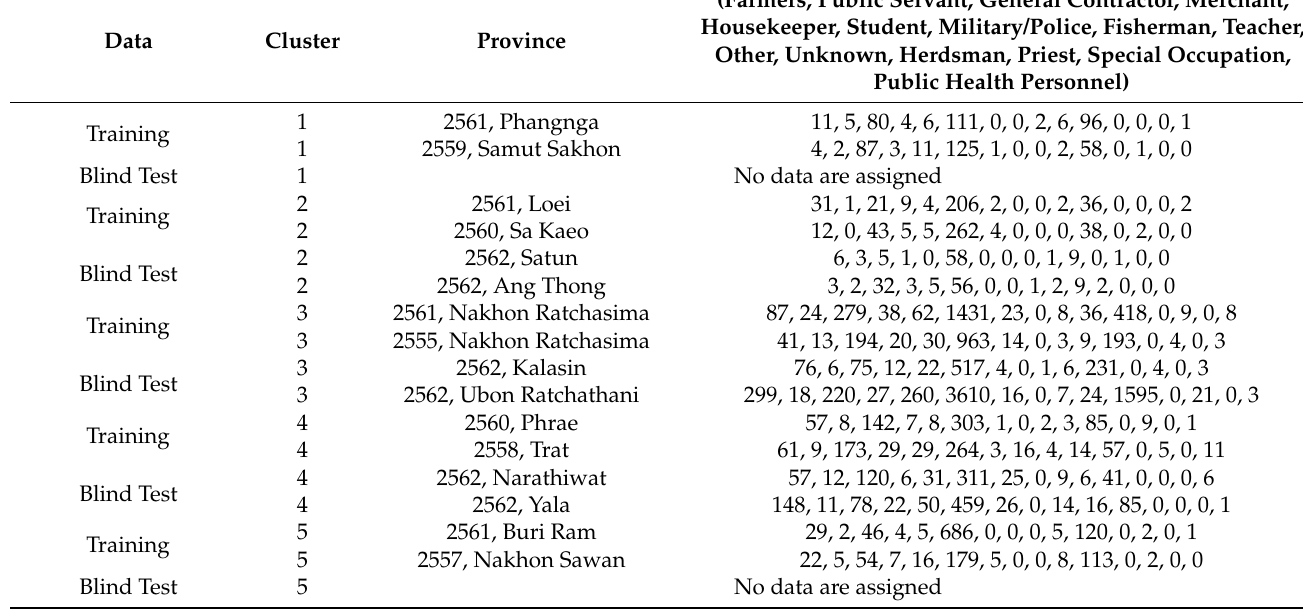
Table 10. The example of clustering results from the selected models for the dengue fever dataset for the career category.